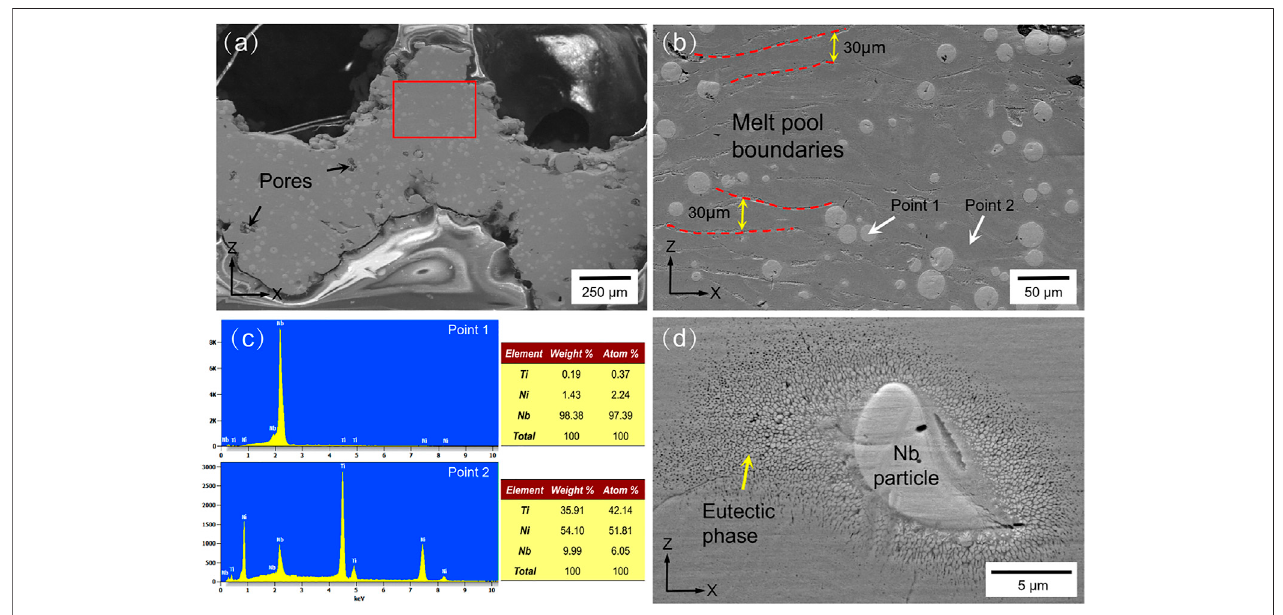
FIGURE 7 | XRD pattern and microstructure images: (A) microstructure images of the scaffold in the XZ section, (B) enlarged image of the red rectangle in (A , C) and EDS spectrums of points 1 and 2 in (B , D) eutectic phase and Nb particles.